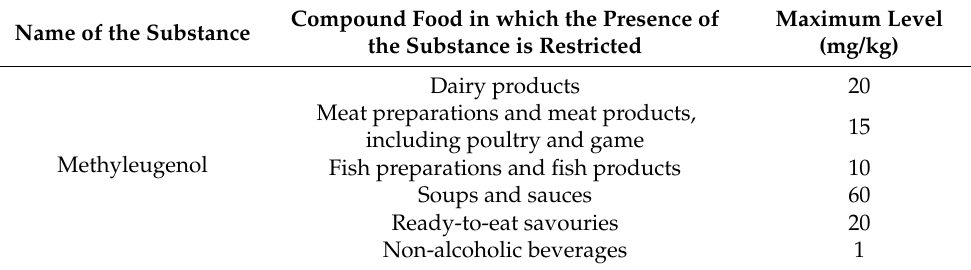
Table 5. Maximum levels of methyleugenol (mg/kg), naturally present in flavorings and food ingredients with flavoring properties, in certain compound food as consumed to which flavorings and/or food ingredients with flavoring properties have been added (abstracted from Annex III, part B in